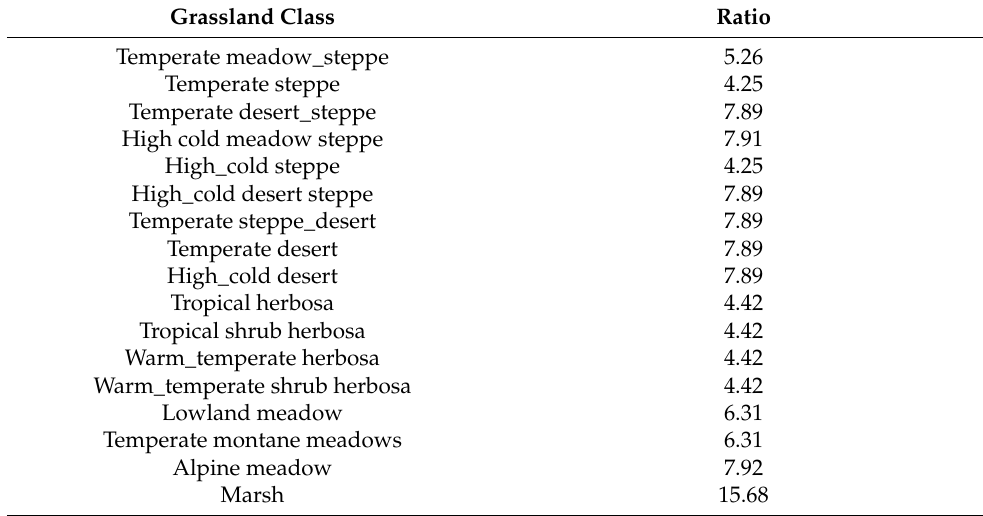
Table A2. The ratio of belowground to aboveground biomass for different grassland classes.